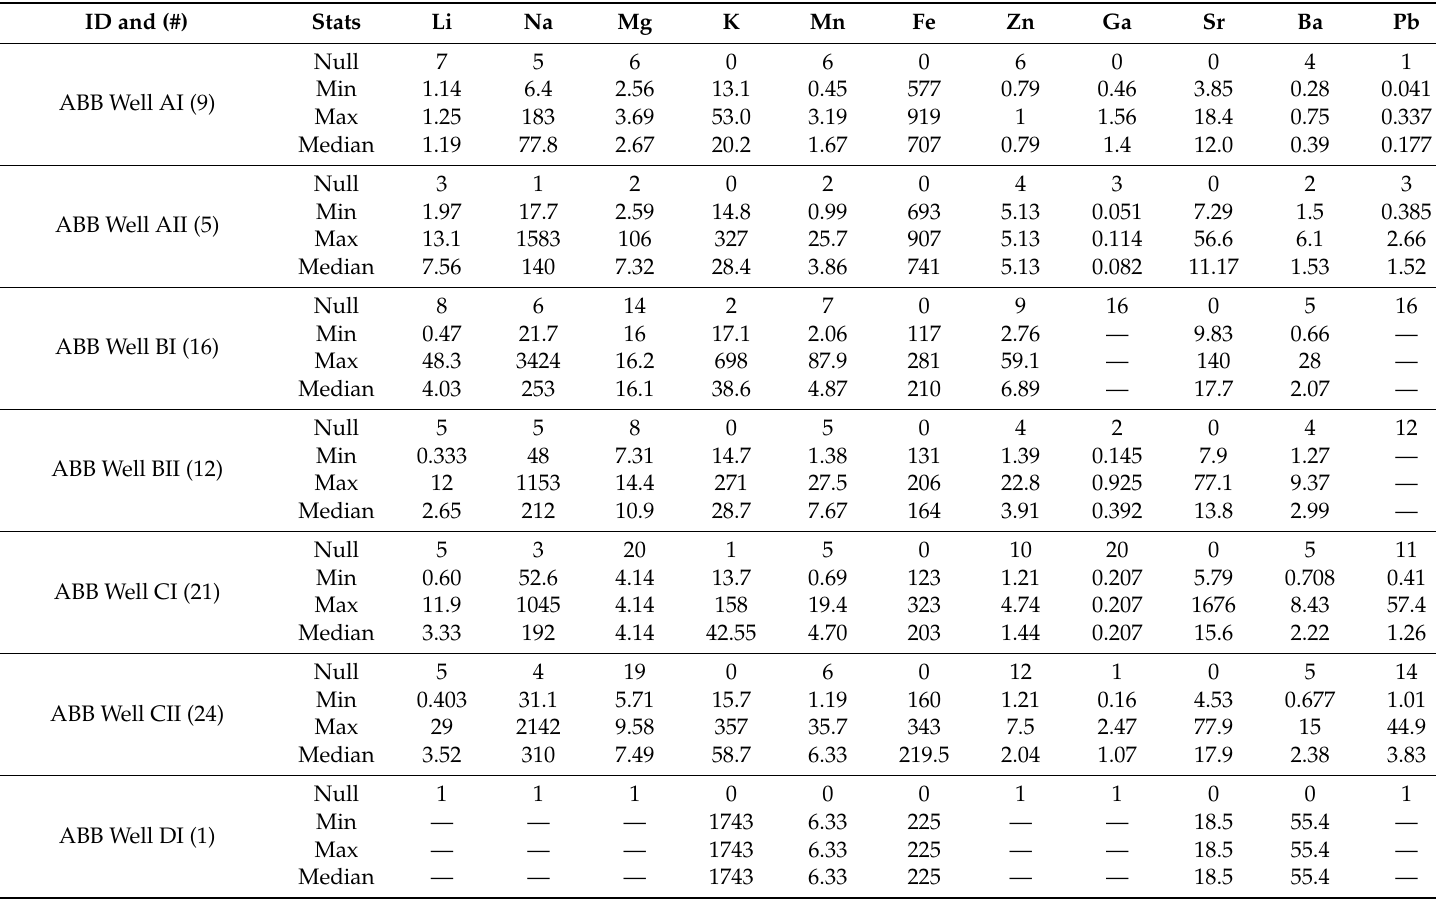
Table 2. LA-ICP-MS minor and trace element data (excluding REY) for fluorite (polished petrographic mounts) from the investigated areas, including total number of in-situ analyses per sample (#) and minimum (Min), maximum (Max) and median values for the sample populations. Null represents the number of analyses that returned values below the detection limit. All concentrations in parts per million